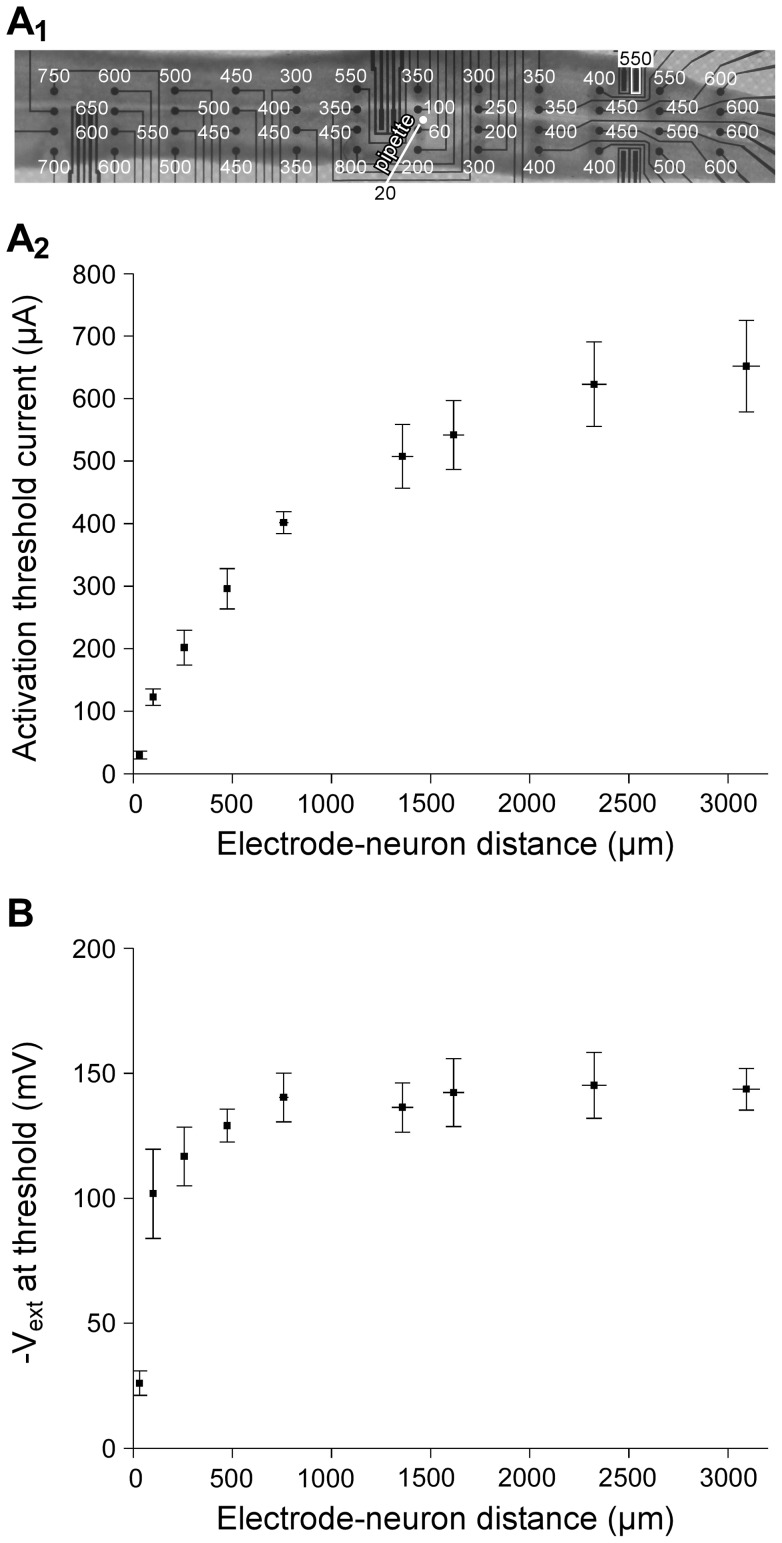
Experimental results. A: Experimental determination of direct activation threshold currents.For each patch-clamped motoneuron, direct activation threshold currents (TCs) were determined by systematically scanning the electrodes of the MEA. A1: Example of thresholds obtained for most electrodes of an array (ranging from 60 to 800 µA) and a stimulating pipette located 20 µm from the soma of the recorded neuron (20 µA). A2: The threshold-distance curve, obtained by pooling the results of 9 experiments, displays a non-quadratic increase of TCs with distance. For instance, on average, TCs reached 200 µA at 250 µm, and 550 µA at 1.6 mm, which is only 2.75 higher. B: Evolution of the extracellular potential values at threshold with distance. The amplitude of the extracellular potential field was measured at the end of the cathodic phase of the threshold stimulation. The average potential-distance curve (n = 9) shows that this value increases sharply in the first hundred microns and then stagnates at about 140 mV, meaning that action potentials are elicited at the moment when Vext reaches this value.